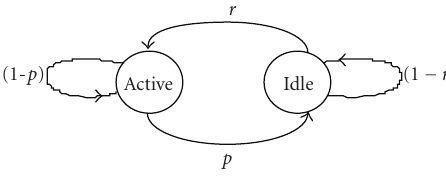
Figure 2: A two-state ON-OFF model.